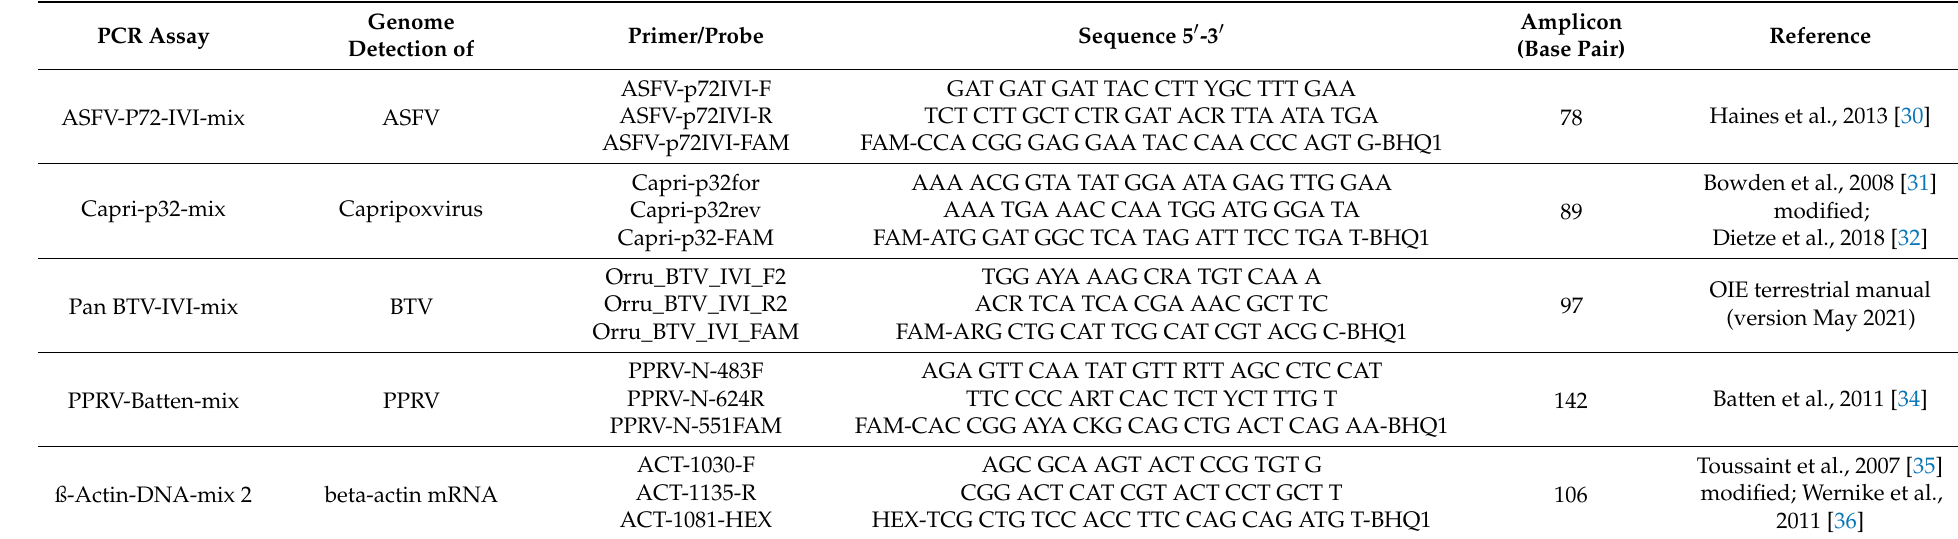
Table 1. Sequences of primers and